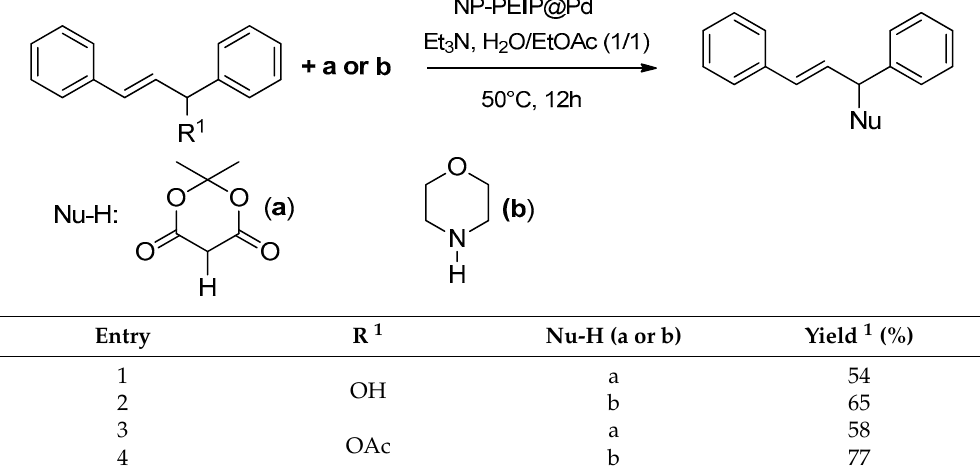
Table 3. Use of NP-PEIP@Pd as catalyst in Mizoroki-Heck couplings.